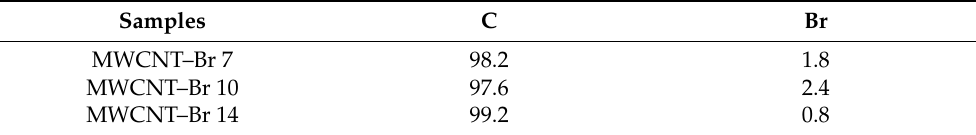
Table 1. Chemical analysis in microareas by energy dispersive X-ray spectroscopy (EDX) (wt%). Samples